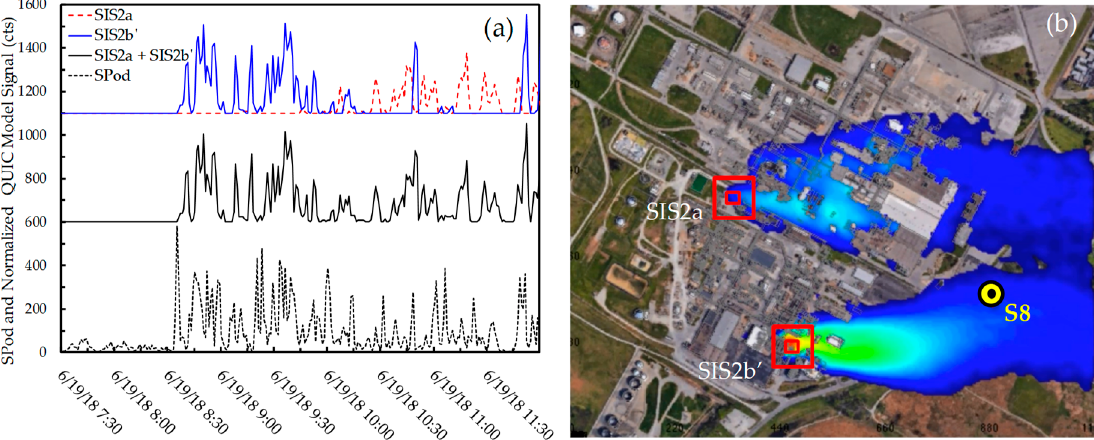
Figure 8. ( a ) Comparison of one-minute time average SPod readings from S8 (bottom panel) with QUIC model simulated emission time series from SIS2a (red dashed trace top panel), SIS2b’ (blue trace top panel), and a composite result of SIS2a and SIS2b’ (middle panel), ( b ) frame of QUIC model video (Video SI5) at 10:15 on 6/19/2018.